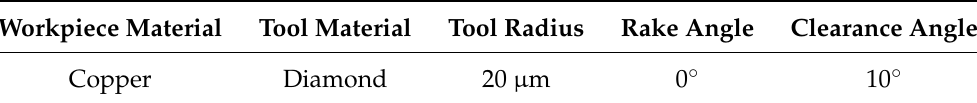
Table 4. The workpiece and tool used in the